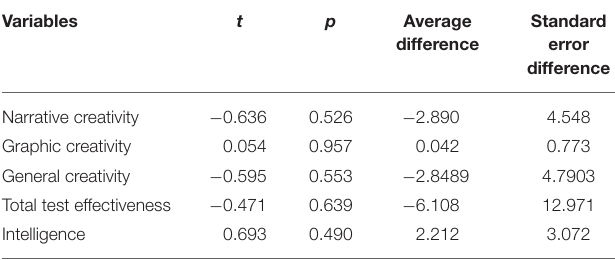
TABLE 1 | Gender differences in the levels of the variables. TABLE 2 | Differences according to educational level in the levels of the variables.